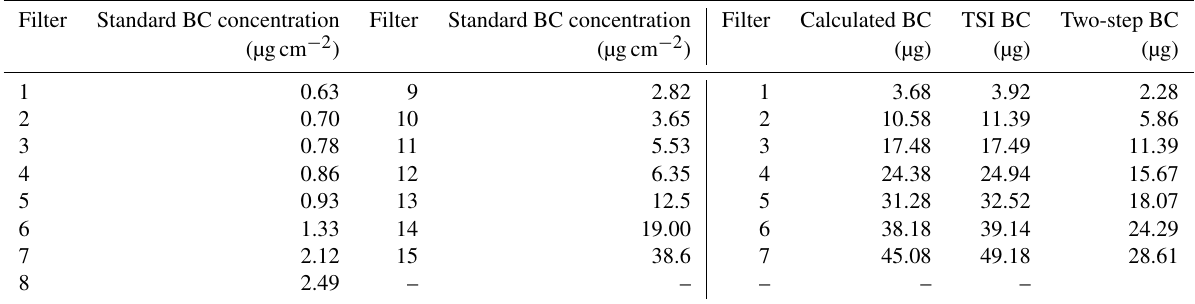
Table 1. Series of 15 standard filters loaded with fullerene soot and a comparison of BC concentrations between theoretical calculations and the TSI and two-step thermal–optical methods in the laboratory. Filter Standard BC concentration Filter Standard BC concentration Filter Calculated BC TSI BC Two-step